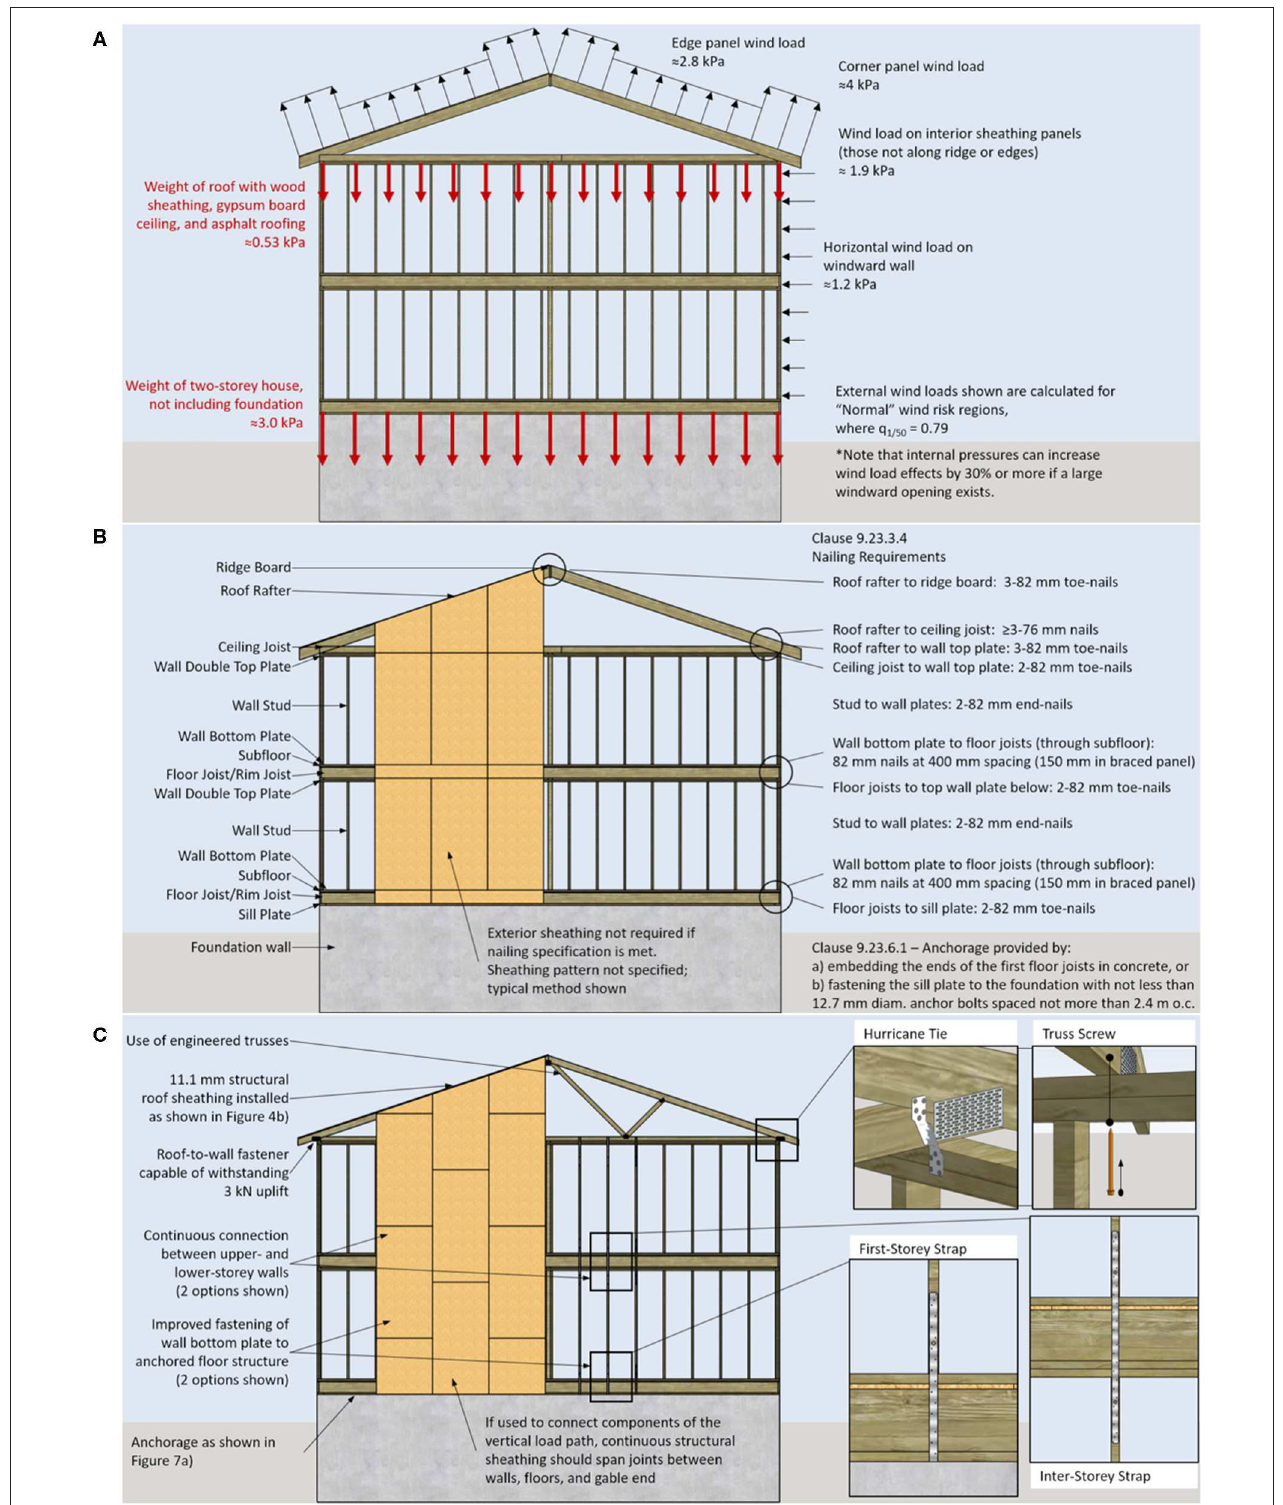
FIGURE 2 | (A) Diagram of external wind load distribution used in the design of structural components and cladding, with estimated self-weight at the roof and ground levels shown for comparison, (B) Diagram showing an example design currently allowed by the NBCC (Canadian Commission on Building and Fire Codes, 2015), with element nomenclature and relevant clauses labeled, (C) Diagram with recommended design components, based on the recommendations in Sandink et al. (2018).